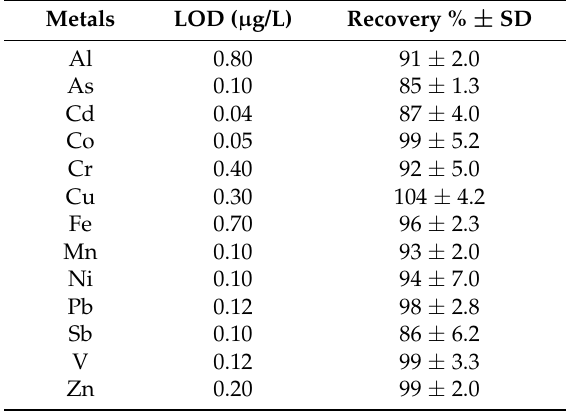
Table 1. Limits of detection (LODs) of analyzed metals and Recovery % ± SD (standard deviation) values after